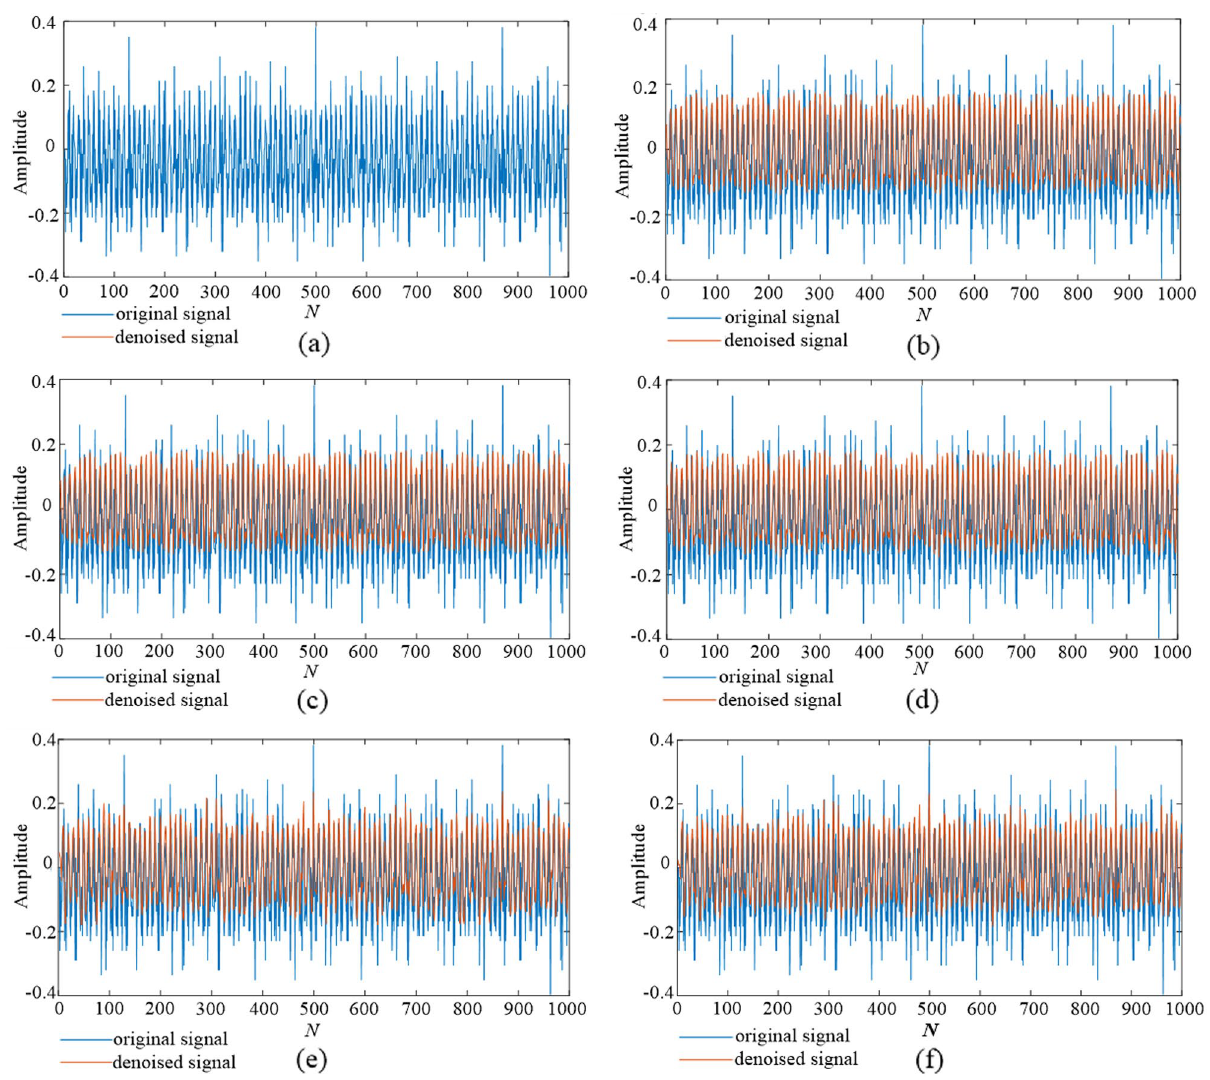
Figure 15. The denoising results of 5 different methods. ( a ) original signal. ( b ) TS-WOA-VMD-CA-WT. ( c ) WOA-VMD-CA-WT. ( d ) TS-VMD-CA-WT. ( e ) EMD-CA-WT. ( f )